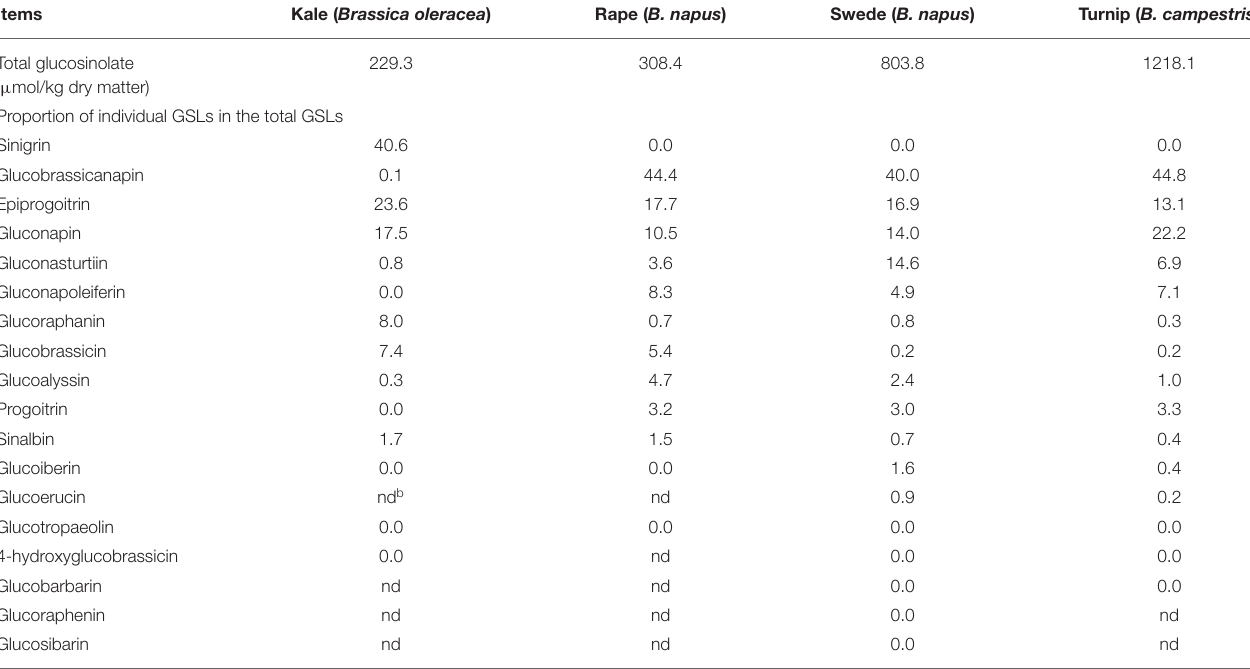
TABLE 1 | Concentration of total glucosinolates (GSLs) and proportion of individual GSLs in brassica forages a .